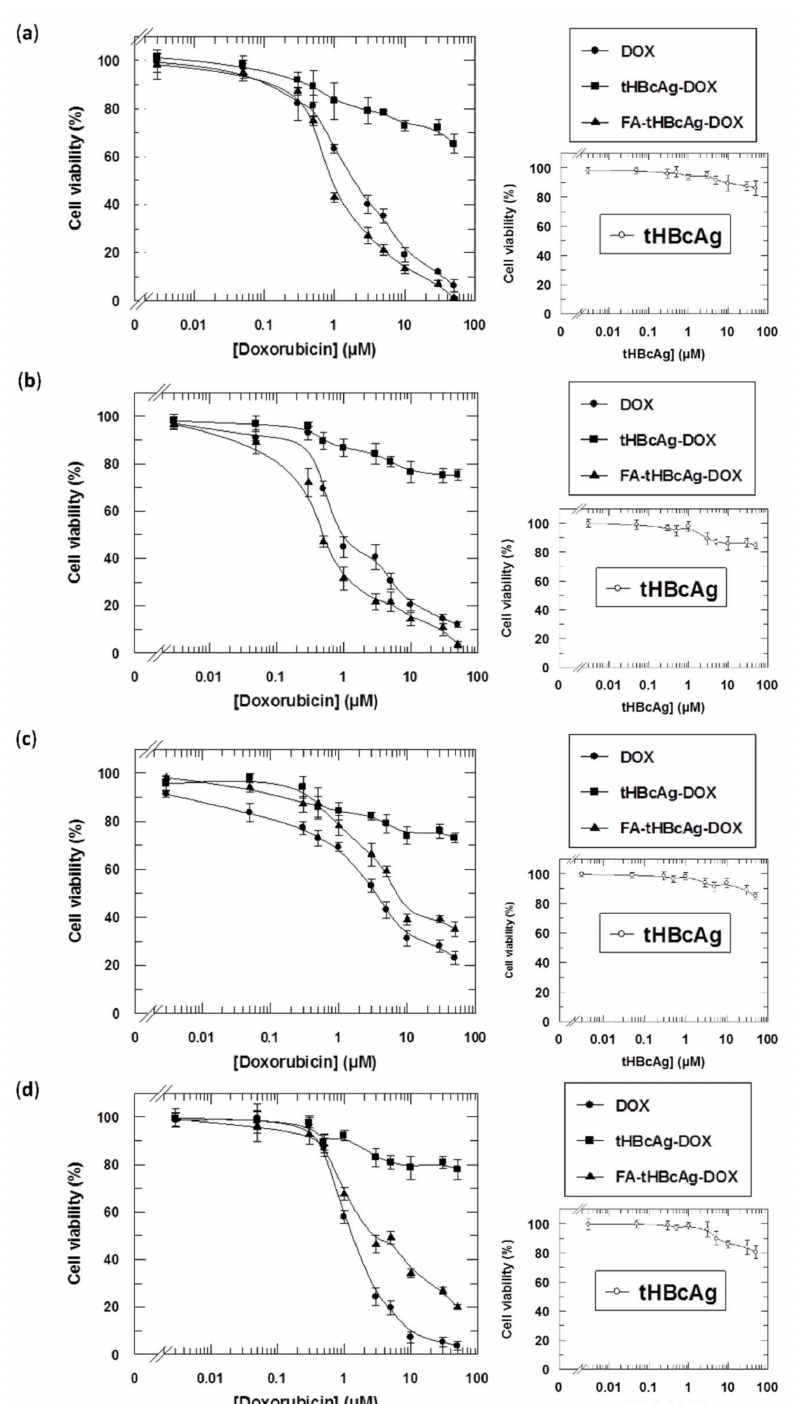
Figure 9. Viability of cancer and normal cells after being treated with tHBcAg VLNPs conjugated with doxorubicin and folic acid at equal DOX concentrations. Viability of cancer ( a ) HeLa; ( b ) HT29 cells; and normal ( c ) 3T3; ( d ) CCD-112 cells. tHBcAg VLNPs conjugated with folic acid (FA) and doxorubicin (DOX) (FA-tHBcAg-DOX) were more efficient in inhibiting the growth of cancer HeLa and HT29 cells than other formulations. By contrast, conjugation of DOX to the FA-conjugated tHBcAg VLNPs led to a decrease in cytotoxicity on normal 3T3 and CCD-112 cells, resulting in protection of the normal cells against DOX. Data represent means ± SDs of triplicate determinations. The small graphs on the right show that tHBcAg VLNPs (tHBcAg) are not toxic to the tested cancer and normal